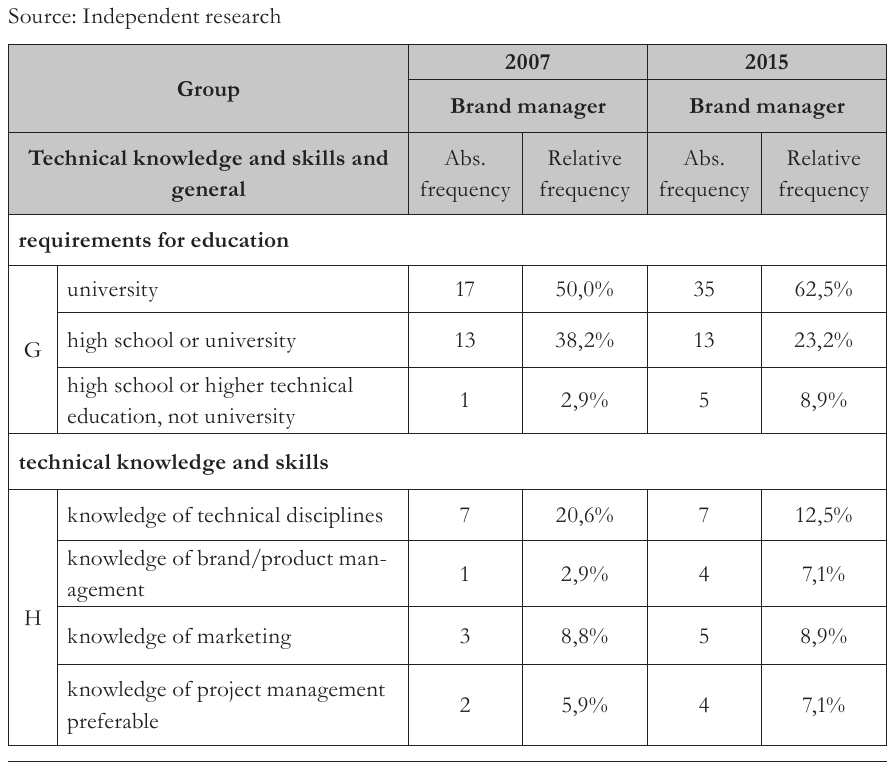
Tab. 1 - Comparison of requirements for a brand manager by advertisers in 2007 and